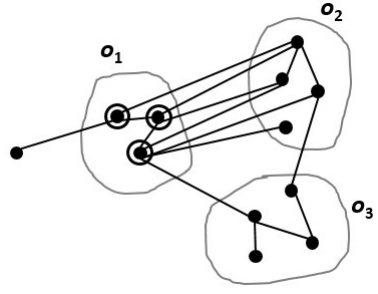
Figure 5: Nodes belonging to the upper approxima- tion ICSN ( o 1 → o 2 ) of the inter-component saccade neighborhood, from o 1 to o 2